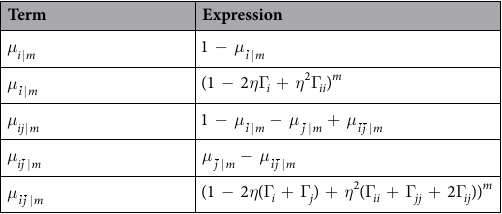
Table 1. Probabilities of single detection µ m . Γ pq is the joint probability distribution, Γ p is the marginal, and η is the detection quantum efficiency. Barred subscript indicates no